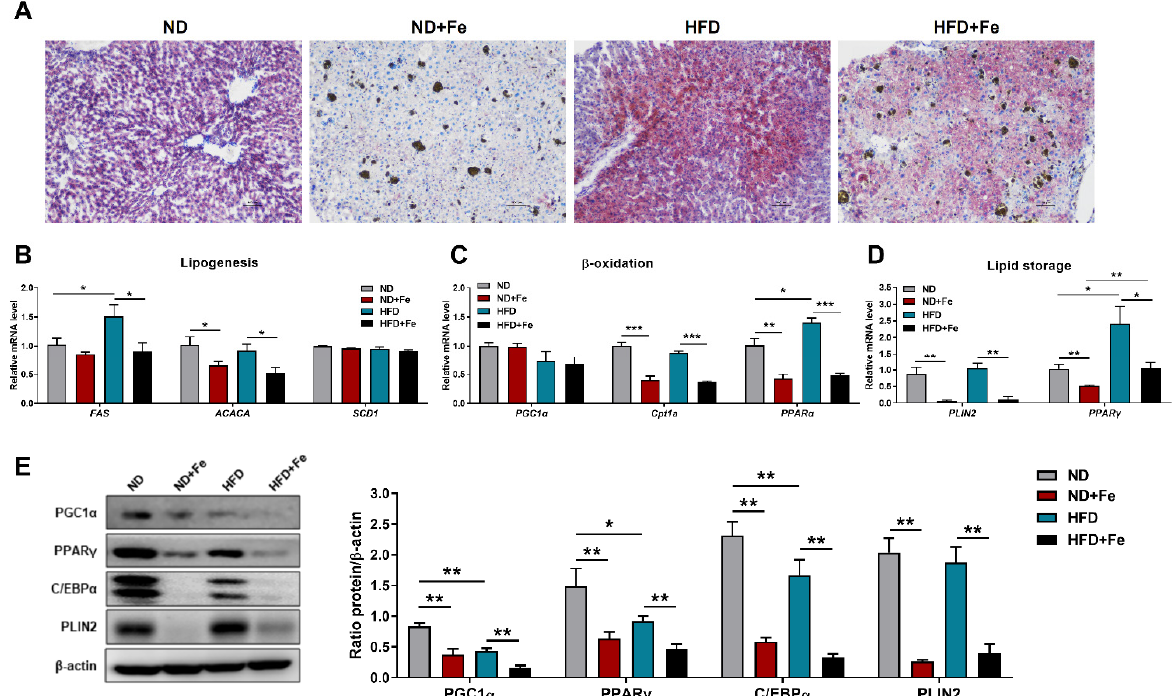
Figure 3. Decreased lipidoses in the liver of iron-overloaded mice. ( A ) Representative Oil Red O staining of liver slices; ( B ) Relative expression levels of genes related to lipogenesis (FAS, ACACA, SCD1) in liver samples; ( C ) Relative expression levels of genes related to Cpt1a, PPAR α ) in liver samples; ( D ) Relative expression levels of genes related to lipid storage (PLIN2, PPAR γ ) in liver samples; ( E ) Western blot analysis of PGC1 α , PPAR γ , CEBP/ α , PLIN2 protein expression and their quantification in liver samples. ND ( n = 6), ND + Fe ( n = 7), HFD ( n = 7), and HFD + Fe ( n = 8). The values are the means ± SEMs. * p < 0.05, ** p < 0.01, *** p < 0.001. Significant differences between two groups were analyzed with the two-tailed Student’s t test.